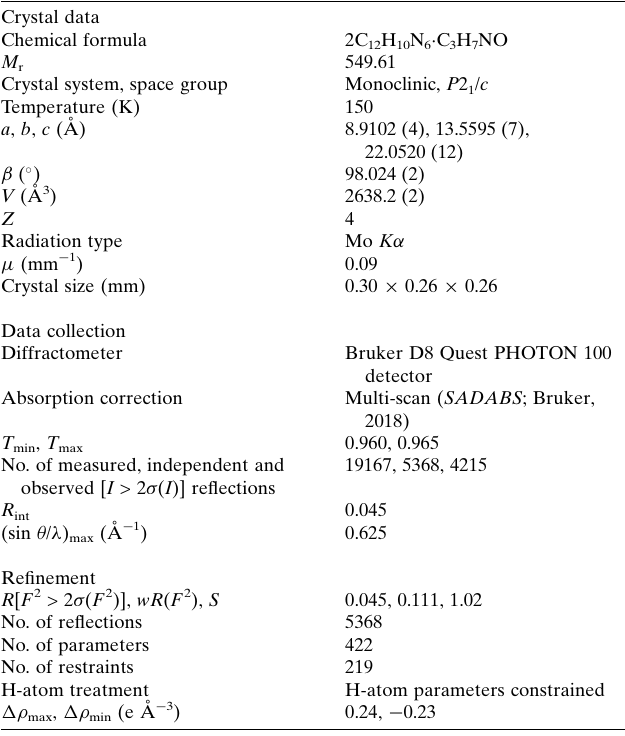
Table 3 Experimental details. Crystal data Chemical